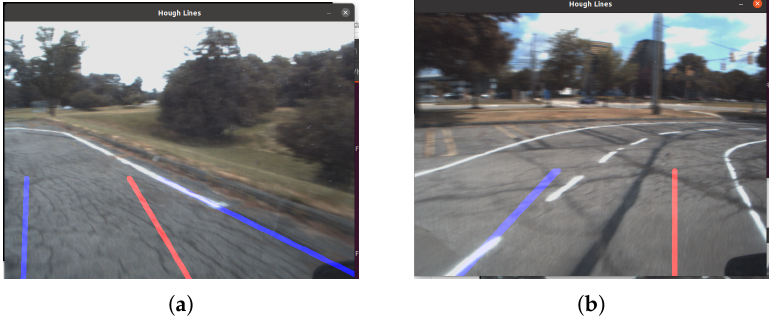
Figure 15. Hough Lines and Average Center Lane Line. The ROI in Figure 17 is used for this method so that the white lines on both sides are detected. Both of these lines are used to create a fictitious center line which is shown in red. ( a ) Outer lane; ( b ) Inner lane.